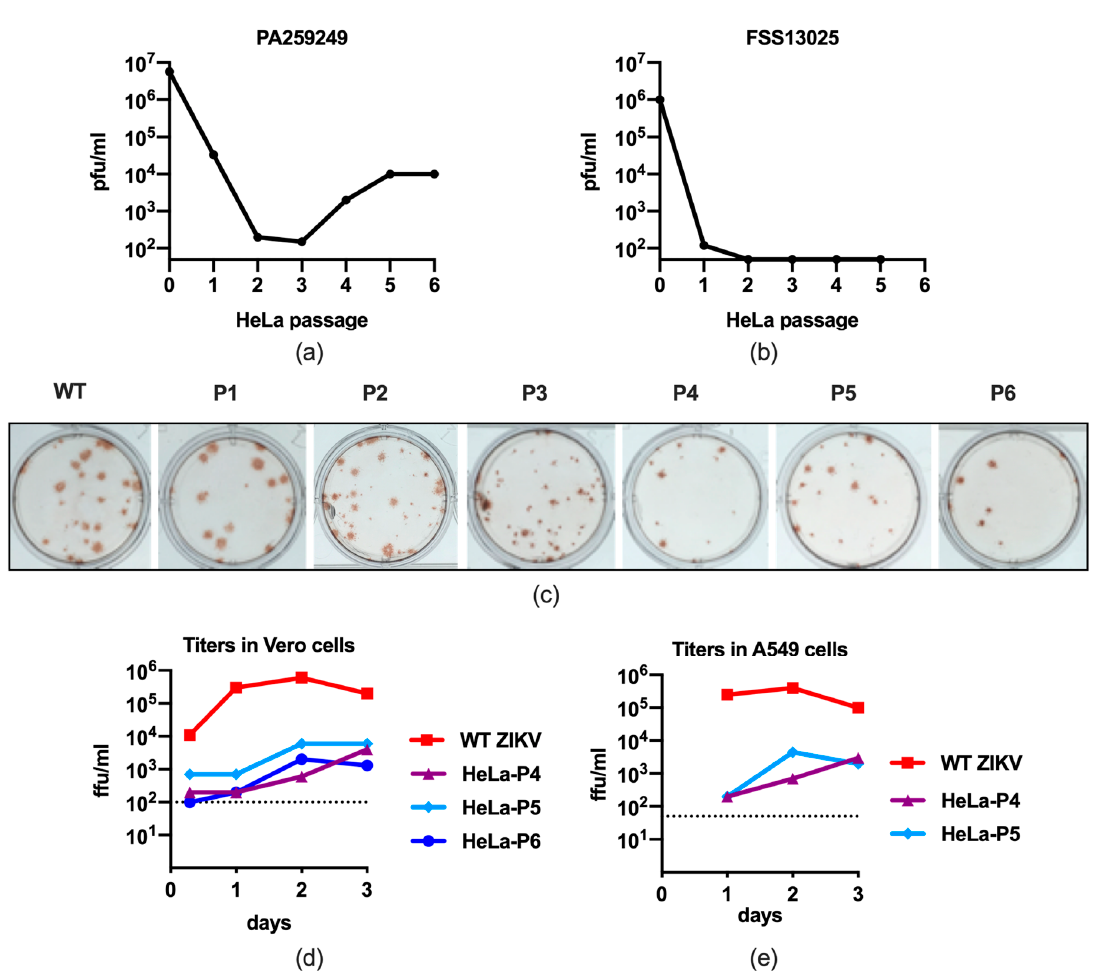
Figure 1. Passaging of ZIKV PA259249 in HeLa cells led to in vitro attenuation. ZIKV strain PA259249 ( a ) or FSS13025 ( b ) was serially passaged in HeLa cells up to six times (P6), and stocks were titrated in Vero cells. Titration limit of detection: 50 pfu (10 1.7 pfu). ( c ) Focus morphology of passaged ZIKV PA259249; ( d ) stocks of WT Zika PA259249 virus serially passaged in HeLa cells, four, five, or six times (WT, HeLa-P4, -P5, and -P6, respectively) were used to infect Vero cells. Duplicate samples were harvested from cell supernatants at 7 hours, 1, 2, or 3 days p.i. and titrated in Vero cells. All titers decreased on days 4 and 5 (not shown). Dashed line: limit of detection: 100 ffu/ml (10 2.0 ffu/ml). ( e ) Stocks of WT Zika strain PA259249 virus HeLa-P4 and -P5 were used to infect A549 cells; duplicate samples harvested from cell supernatants at 1, 2, or 3 days p.i. were titrated in Vero cells. Dashed line: limit of detection: 50 ffu/ml (10 1.7 pfu/ml). Mock-infected cells had no detectable titers in Vero or A549 cells (not shown).